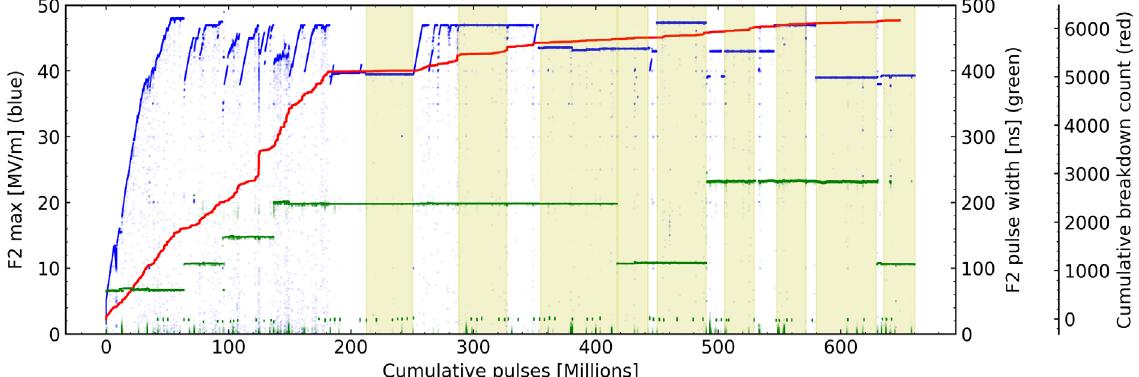
FIG. 4. Overview of the conditioning period, containing all data analyzed. The yellow area represents the runs during which the operational settings were kept stable and which we used for analysis. Additionally, the maximum power amplitude of the forward traveling wave signal F2 (blue), its pulse width (green), and the cumulative breakdown count (red) is shown.